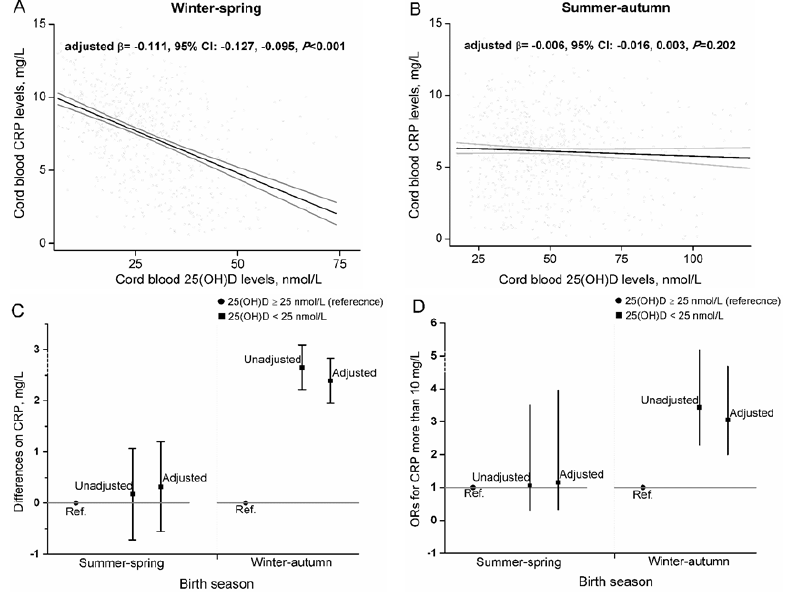
Figure 4. Associations between cord blood 25(OH)D and CRP, stratified by season. The adjusted linear relation was assessed by multiple linear models in neonates born in winter-spring ( A , n = 699) and summer-autumn ( B , n = 792). The solid black line denotes the fit of the regression model, the solid grey line denote 95% CI ( A , B ). The adjusted differences on CRP levels ( C ) and adjusted ORs of CRP ≥10 mg/L ( D ) for neonates with 25(OH)D <25 nmol/L were assessed by multiple linear model. Potential confounders included maternal sociodemographic characteristics, perinatal health status, lifestyle, and birth outcomes. Bars represent regression coefficients ( C ) or ORs ( D ), with 95% CI.